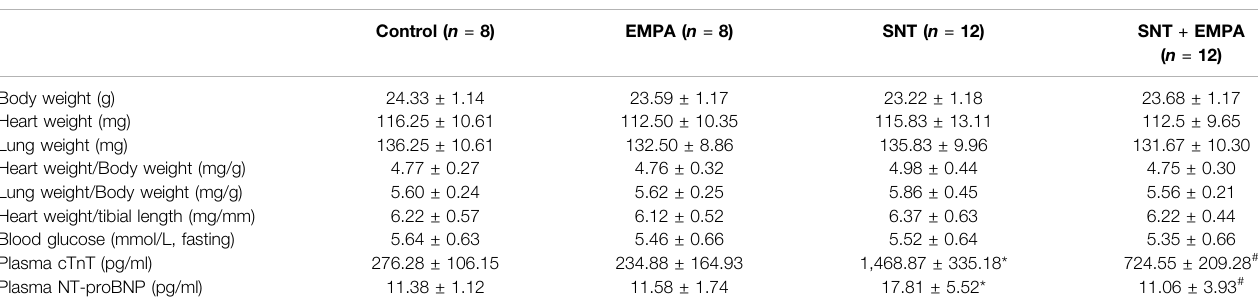
TABLE 1 | Weight, glucose, and blood parameters at the study endpoint.